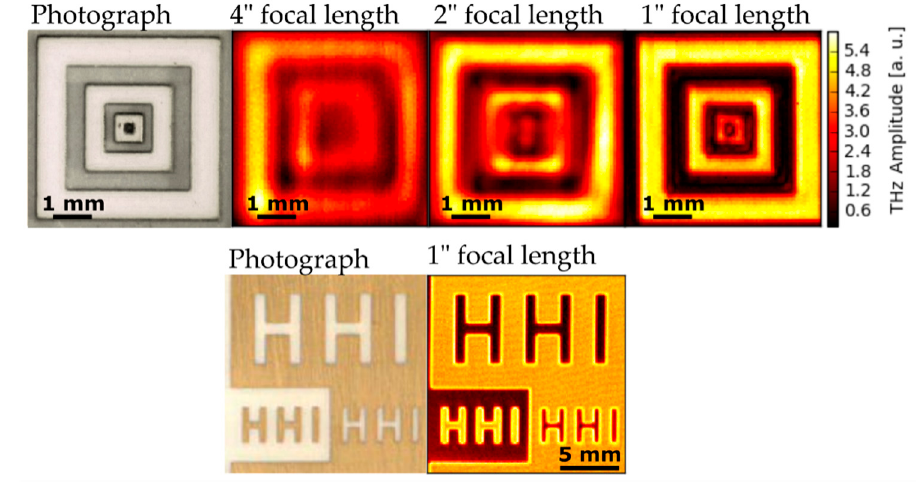
Figure 7. THz imaging experiments with the THz transceiver module. Mirrors with three different focal lengths are compared. Top row: photograph and THz reflection maps of a ceramic sample with a pattern etched into its surface. The reflection maps show the reflected peak-to-peak THz amplitude of the upmost surface. A frequency high pass for the THz spectrum at 1.5 THz was used to limit the spectral range. Bottom row: photograph and reflection amplitude map of a gold pattern on a ceramic sample. This THz image was recorded using the 1” focal length mirror.